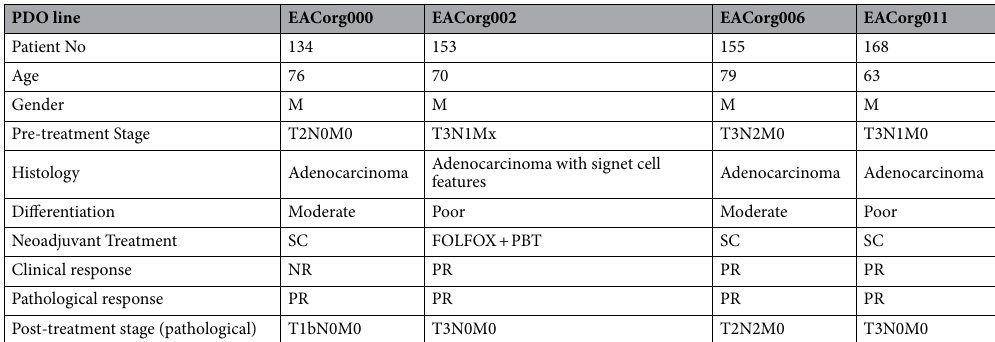
Table 1. Patient characteristics. SC standard of care, platinum-based doublet with paclitaxel and radiation therapy, PBT proton beam therapy, PR/NR partial response/no response, FOLFOX Folinic acid-5-Fluorouracil-